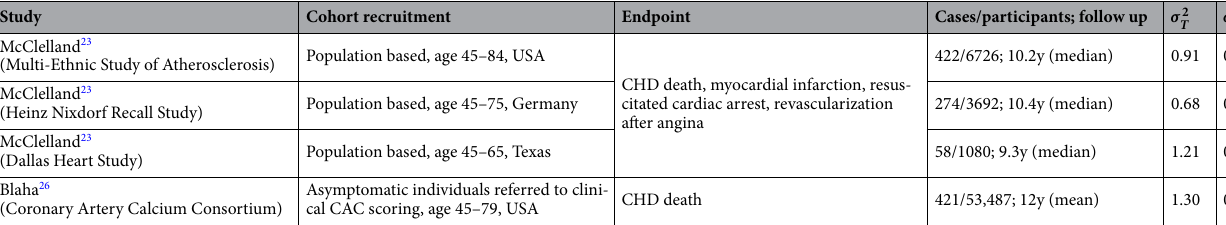
2 T ) and additional